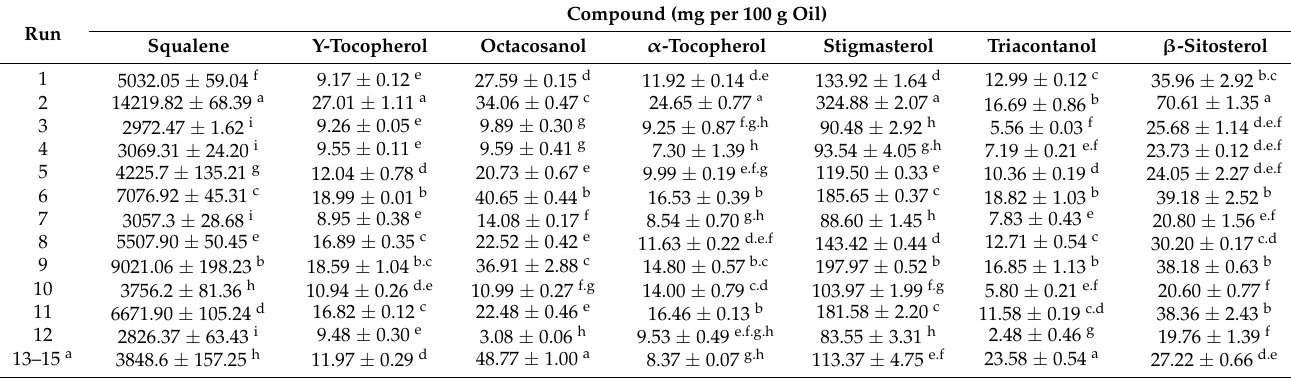
Table 5. Bioactive compounds of pequi almond oils obtained by supercritical CO 2